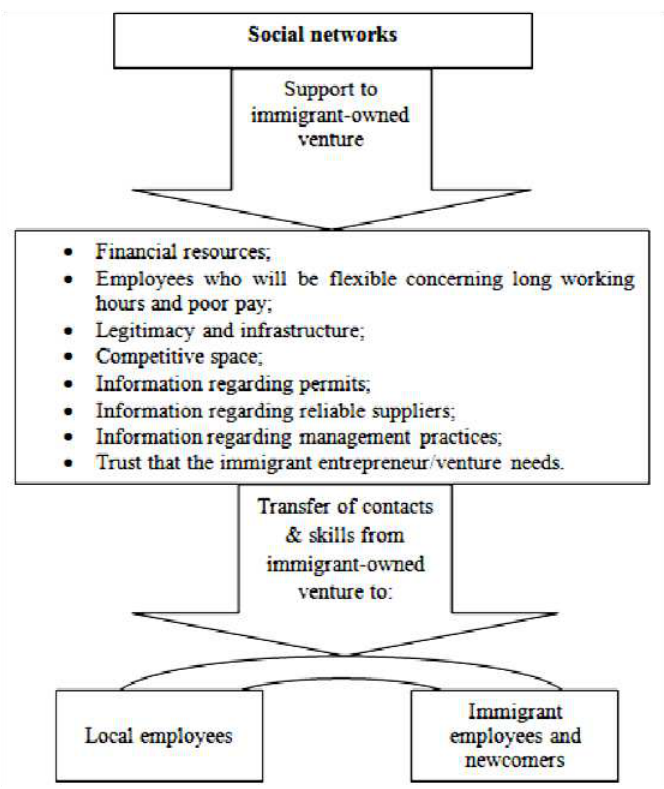
Fig. 1. Flowchart summary of social networks support to immigrant-owned ventures Source: